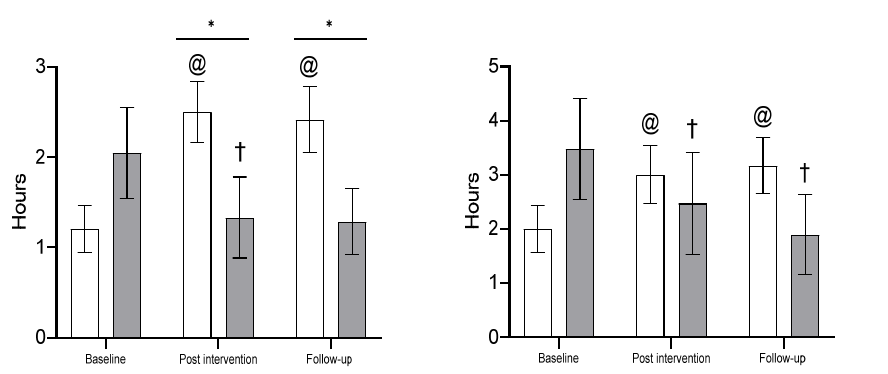
Figure 3. Computer games (hours) weekdays and weekend at baseline, post-intervention and follow- up, intervention and control groups. * p < 0.05, † different from intervention baseline, @ different from control baseline.